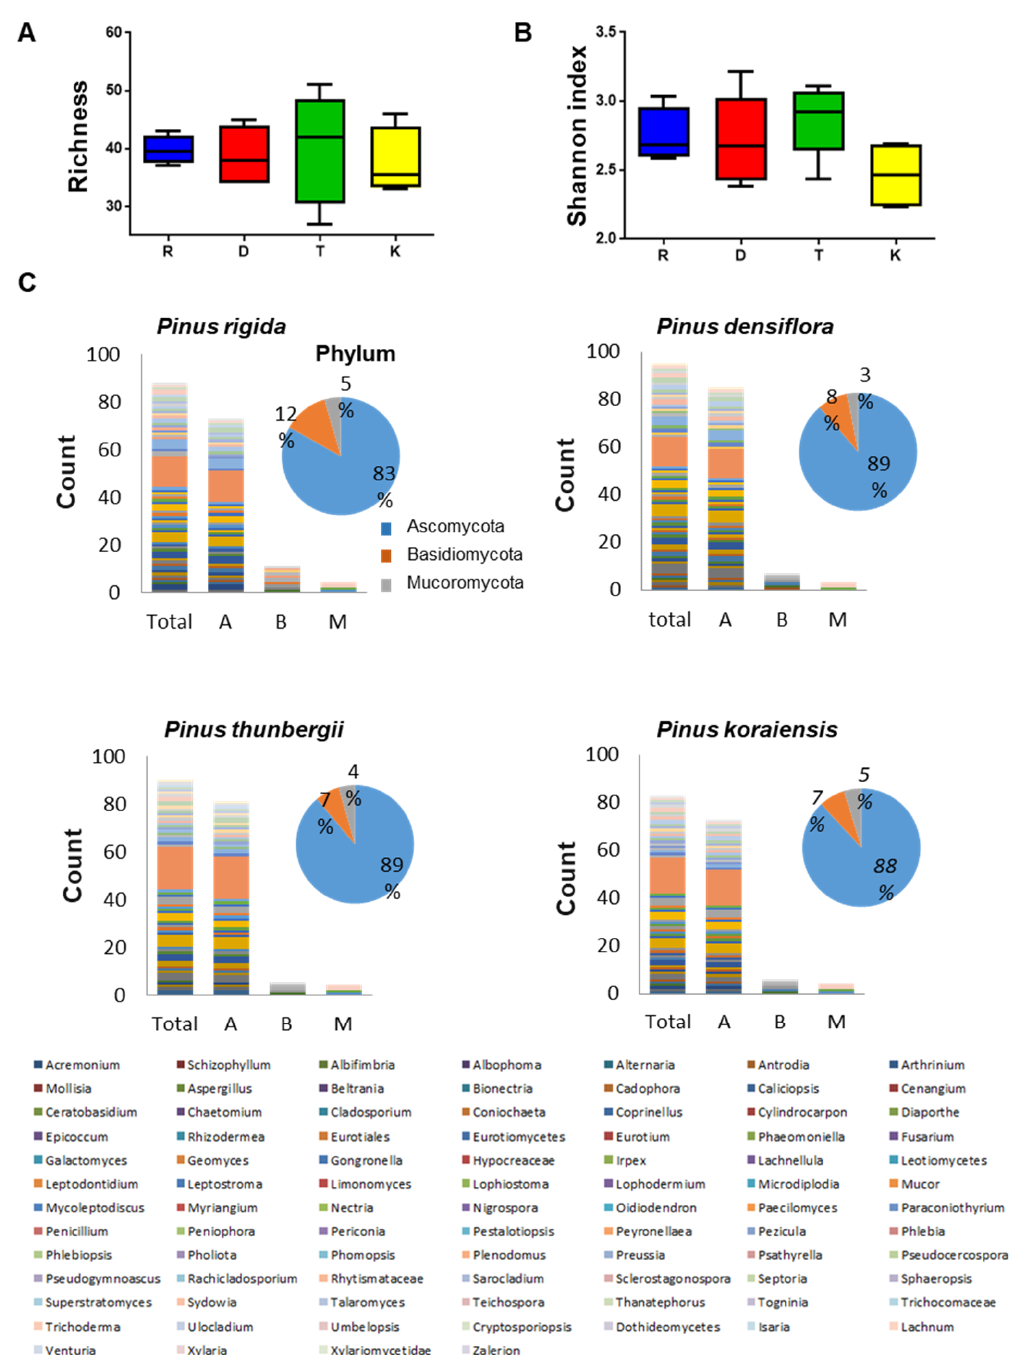
Figure 6. Distribution and diversity of fungal endophytes within four Pinus species. ( A ) Species richness in P. rigida (R), P. densiflora (D), P. thunbergii (T), and P. koraiensis (K). ( B ) Shannon index in P. rigida (R), P. densiflora (D), P. thunbergii (T), and P. koraiensis (K). ( C ) Bar plot showing the number of OTUs belonging to each of the 88 total genera recovered. The pie charts show the percentage of isolated fungal endophytes belonging to the different phyla. Letters A, B and M represent the phyla Ascomycota, Basidiomycota and Mucoromycota,